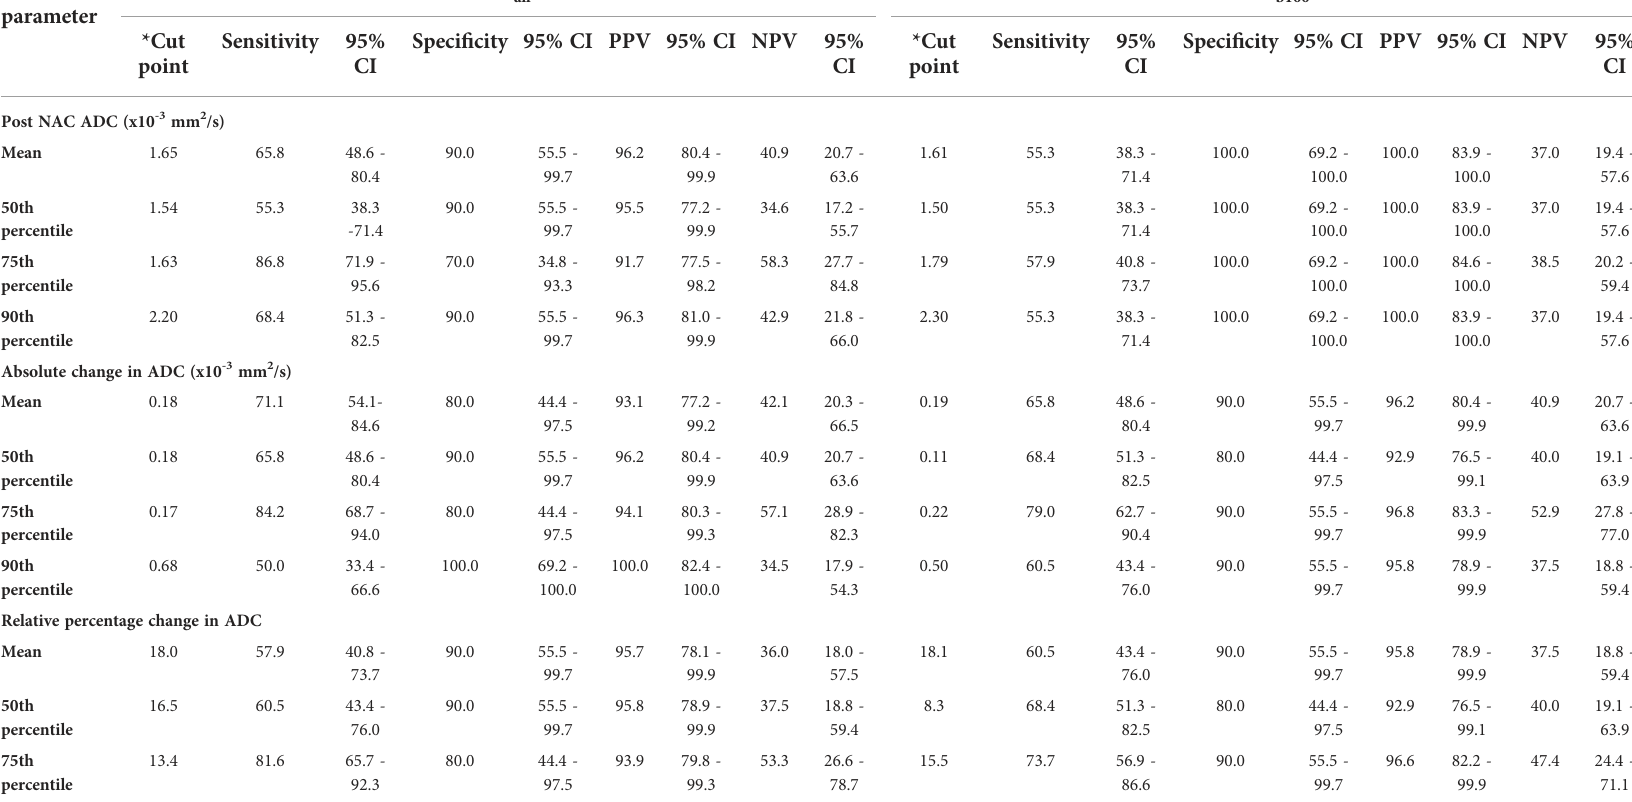
TABLE 3 Predictive power of neo-adjuvant chemotherapy response derived from signi fi cant ADC cut point parameters. ADC parameter